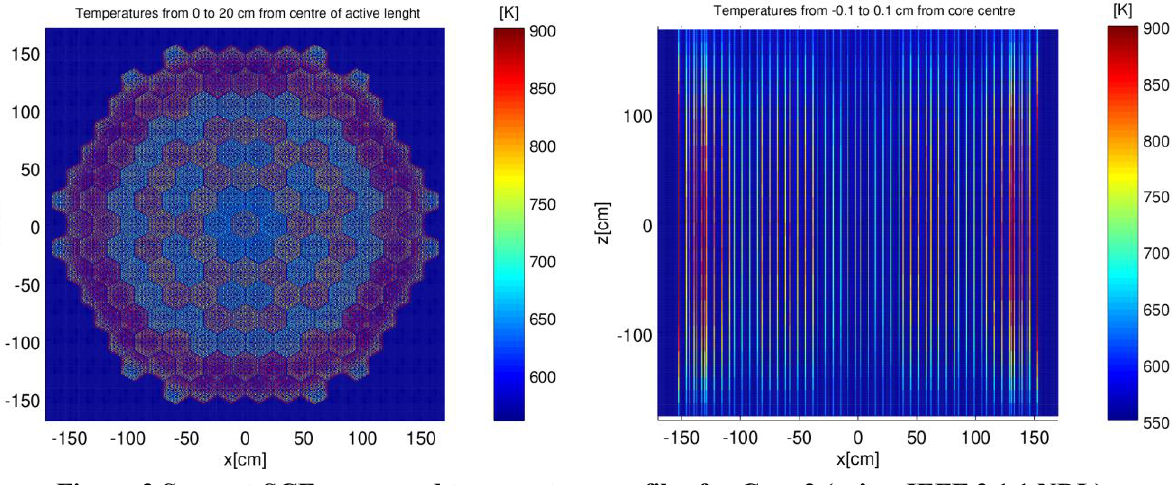
Figure 3 Serpent-SCF converged temperature profiles for Case 2 (using JEFF 3.1.1 NDL)